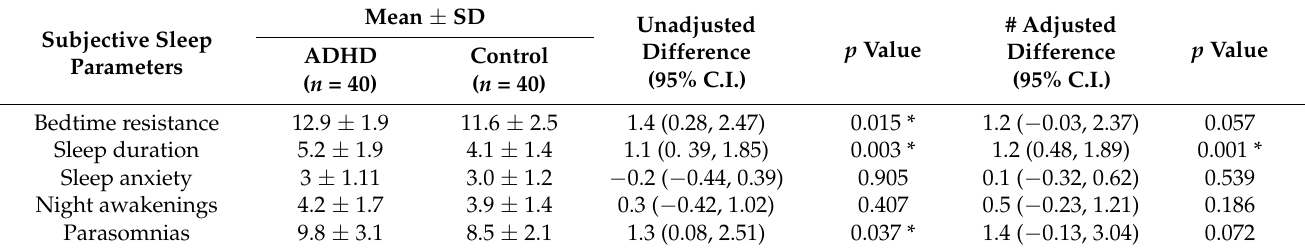
Table 8. Comparison of other subjective sleep parameters between ADHD and control group.